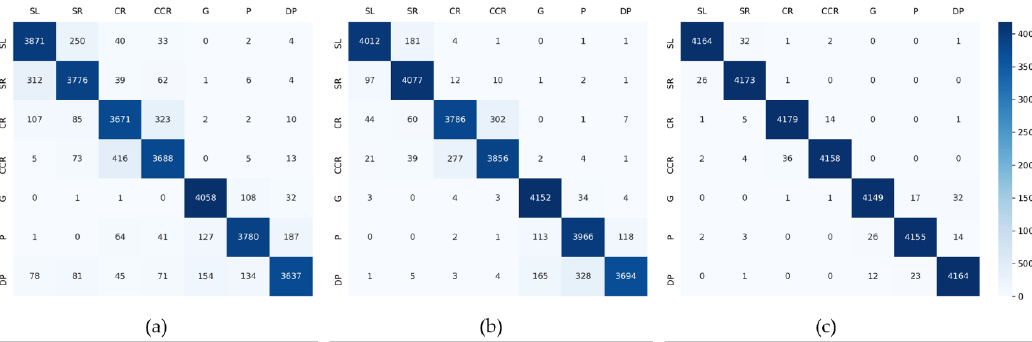
Figure 17. The confusion matrices of each machine learning for the source domain dataset. ( a ) Recurrent neural network (RNN); ( b ) 2D-CNN; ( c ) 3D-CNN.